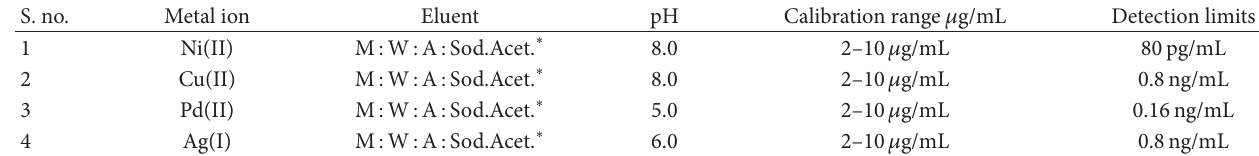
T 2: Quantitative HPLC data for metal ions Cu(II), Ni(II), Pd(II), and Ag(I) using PPS complexing reagent. S.